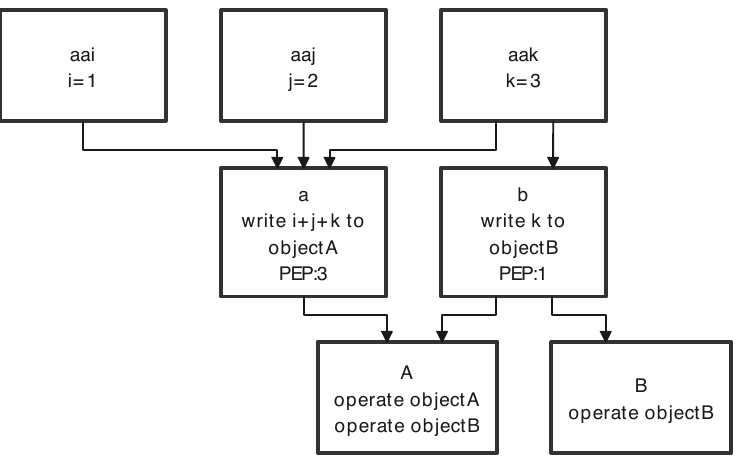
Figure 5. Scoring the potential error